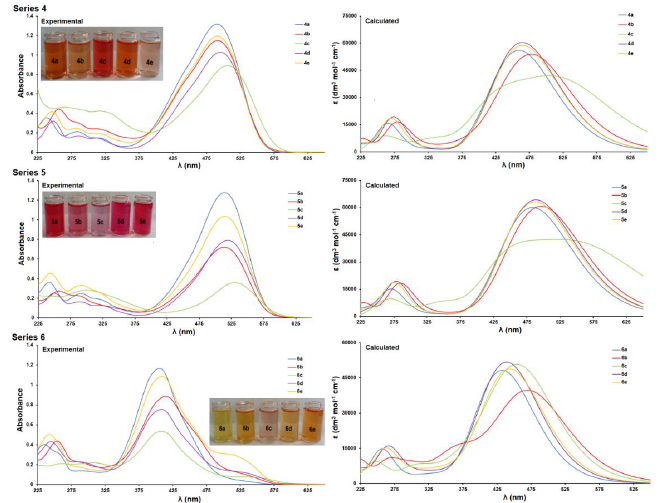
Figure 1. UV-Vis absorption spectra of the studied azo dyes in MeOH at a concentration of 4.0 × 10 − 5 mol/L at room temperature: ( Series 4 ) Absorption spectra of azo dyes 4a – e containing 4-aminophenylazo group; ( Series 5 ) absorption spectra of azo dyes 5a – e containing 4-( N,N -dimethylamino)phenylazo group; ( Series 6 ) absorption spectra of azo dyes 6a – e containing 4-hydroxyphenylazo group. Respective calculated spectra are shown as well.